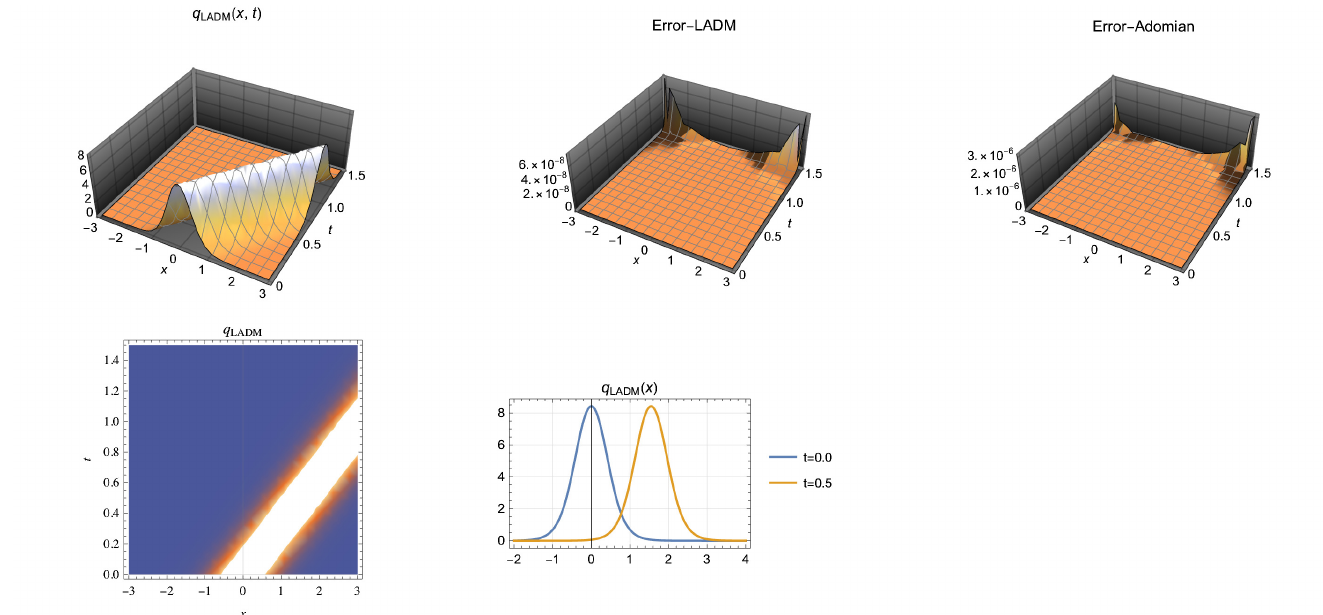
Figure 1. Soliton profile q LADM ( x , t ) in the interval − 3.0 ≤ x ≤ 3.0, for the parameters selected in Case 1 ( above left ). Error by LADM ( above center ) and error by Adomian method ( above right )). Density graph ( bottom left ). Two dimensional (2D) graph for t = 0.0 and t = 0.5 ( bottom right ).